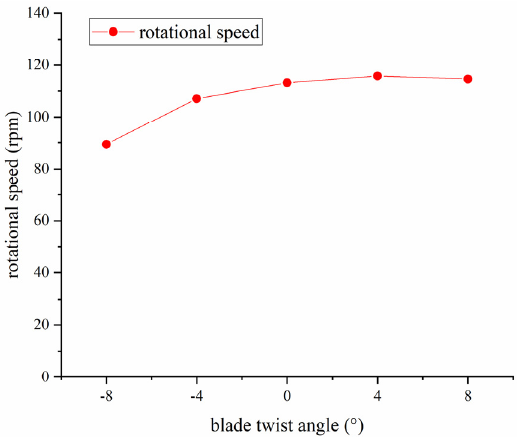
Figure 21. Variation of rotational speed with blade twist angle at δ s = 40 ◦ , θ = 0 ◦ , v = 0.306 m/s. When v = 0.366 m/s, θ = 0 ◦ , and δ s = 40 ◦ , the thrust T and thrust coefficient C T was calculated by CFD simulation with the blade twist angle. Figure 22 shows the thrust and thrust coefficient with various blade twist angle. The thrust has a positive correlation with the blade twist angle, while the thrust coefficient has a negative correlation with the blade twist